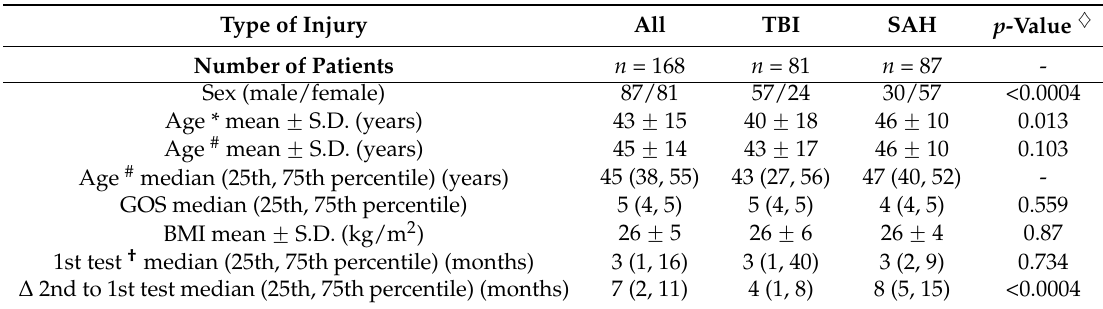
Table 3. Subject